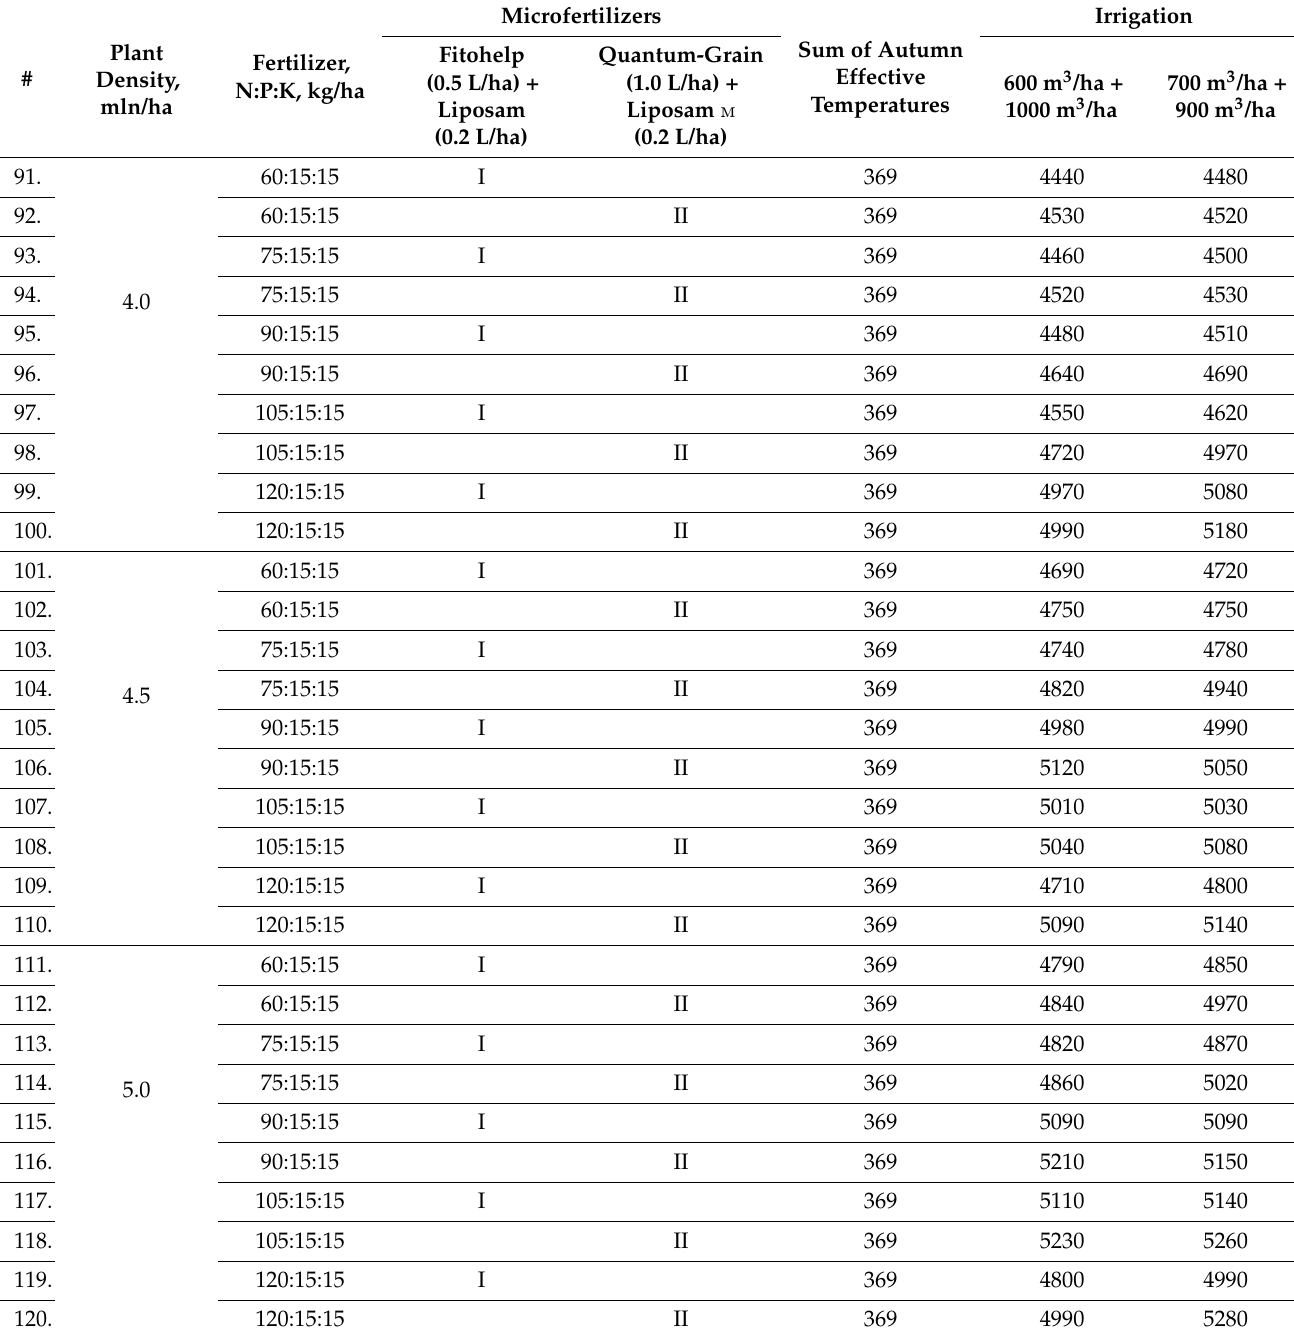
Table A2. Yields, kg/ha (preceding